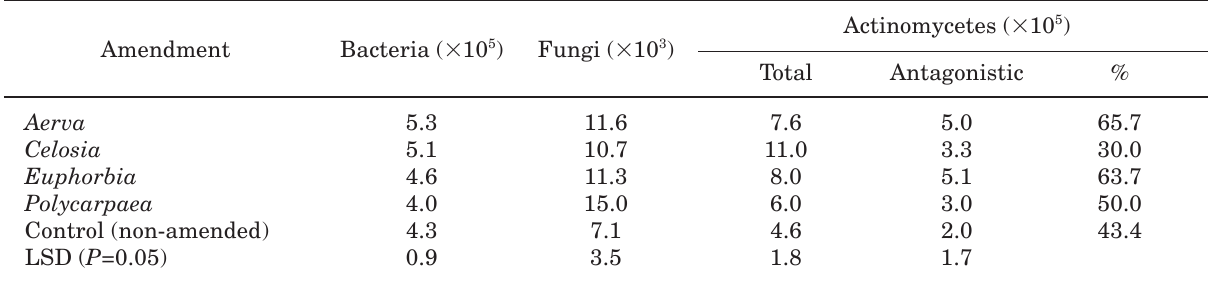
Table 3. Effect of field soil with and without weed residue amendment on total numbers of bacteria, fungi, actino- mycetes and antagonistic actinomycetes (g -1 soil) after harvest of clusterbean (November